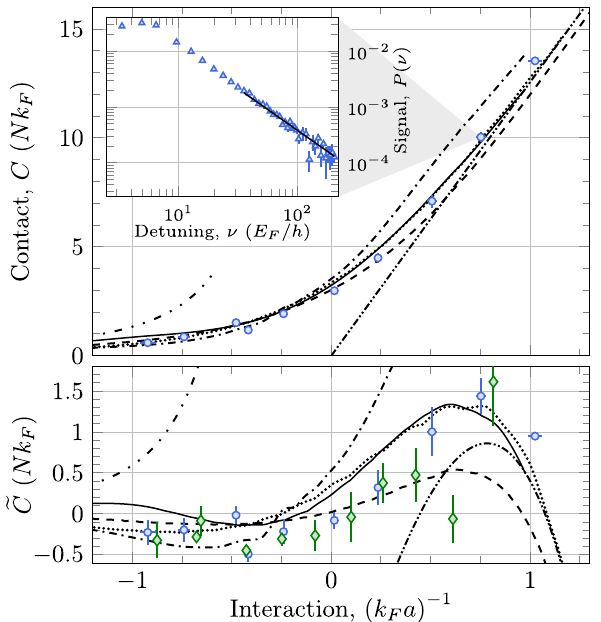
FIG. 8. The contact of a uniform Fermi gas in the BEC-BCS crossover. The contact is extracted from the tail of rf line shapes taken at different interaction parameters. As an example, the inset a Þ − 1 ¼ 0 . 75 ð 2 Þ together with its fit shows the line shape at ð k F (black solid line). Upper: The theoretical prediction for the contact in the BCS (BEC) limit is shown as a loosely (densely) dash-double-dotted line. We compare our data (blue circles) with a non-self-consistent T -matrix model at T ¼ T improved by c Popov (dash-dotted line) and at T ¼ 0 (solid line) [81], a Luttinger-Ward calculation (dashed line) [82], and a GPF calculation (dotted line) [83,84]. The FNDMC line [78,85] is indistinguishable from the GPF line on this scale. Lower: For a better quantitative comparison, we define a shifted contact as ˜ C ¼ C − 3 exp ð 1 . 4 =k a Þ . In this plot, we also add previous F measurements done with a quasihomogeneous gas (green dia- monds) [35]. Error bars represent 1 σ confidence interval of the